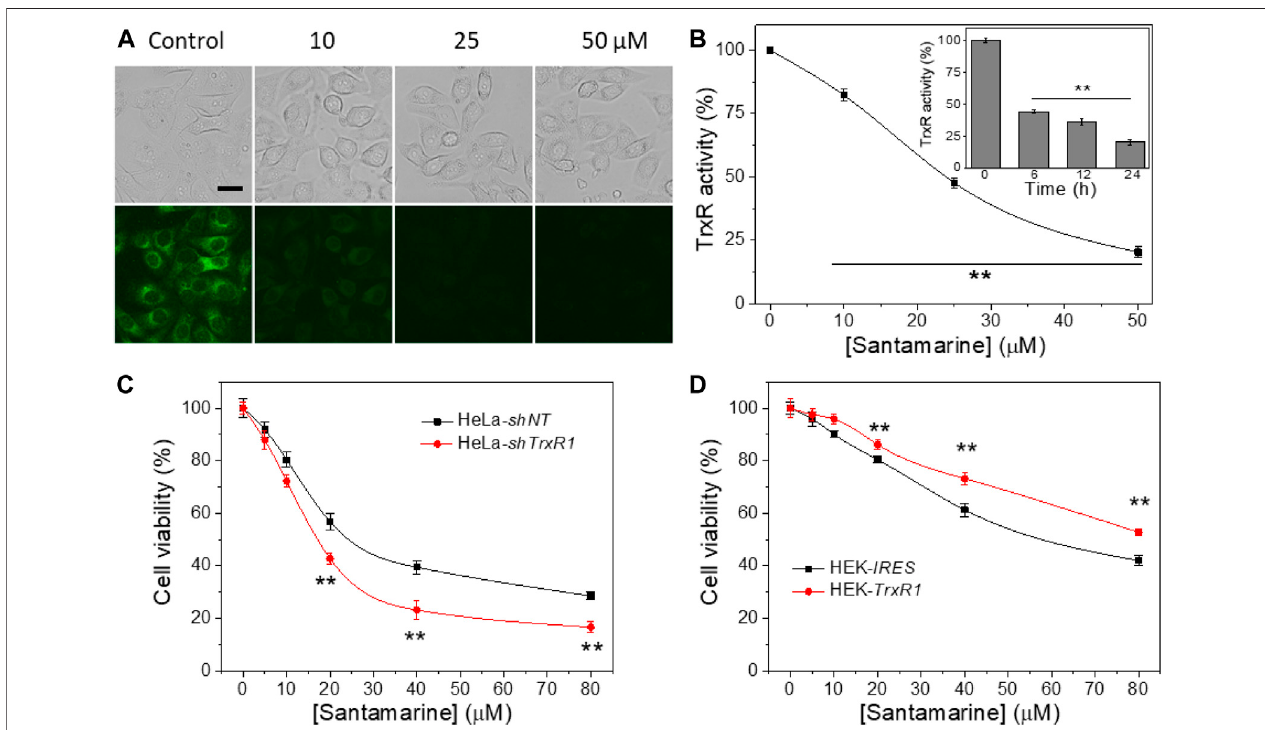
FIGURE 4 | TrxR is a target for santamarine in cells. (A) Santamarine inhibited TrxR activity in live HeLa cells, as assessed by TRFS-green imaging. The top panel (bright fi eld pictures) and the bottom panel ( fl uorescence pictures) were acquired by an inverted fl uorescence microscope. The images represent three independent experiments performed in triplicate. Scale bar: 20 μ m. (B) The effect of santamarine treatment on TrxR activity of HeLa cells was evaluated by the endpoint insulin reductionassay.HeLacellsweretreatedwithdifferentconcentrationsofsantamarinefor24h, andthenTrxRactivity incelllysatewasmeasured using anendpoint insulin reduction assay and expressed as a percentage of the DMSO-treated control. The inset in (B) re fl ects the time-dependent inhibition of TrxR by santamarine in HeLacells.AftertheHeLacellsweretreatedwith50 μ Msantamarineforanindicatedtimepoint, theTrxR activityincelllysatewasalsomeasured bytheendpointinsulin reduction assay. (C) and (D) TrxR is indeed involved in the cellular process of santamarine. (C) Knockdown of TrxR1 sensitizes the cells to santamarine treatment. After 48 hoftreatmentofHeLa- shNT cells(control)andHeLa- shTrxR1 cells(knockdown)withtheindicatedconcentrationsofsantamarine,thecellviabilitywasdeterminedby MTT assay. (D) Overexpression of TrxR1 protects the cells from santamarine treatment. The HEK- IRES cells (control) and HEK- TrxR1 (overexpression) cells were with the designed concentrations of santamarine for 48 h, and the cell viability wasassessed by the MTT assay. All data are from three independent experiments in triplicate. ** p < 0.01 versus the control group in (B) , between two cell lines in (C) and (D)